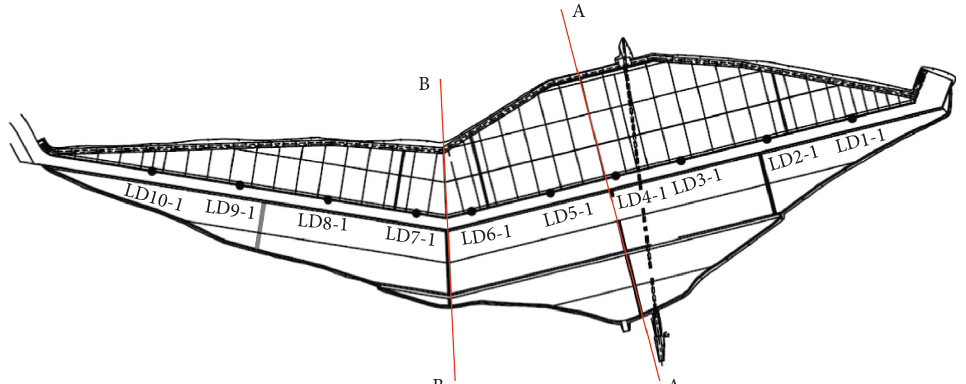
Figure 5: Layout of CFRD and gauging points LD1-1 to